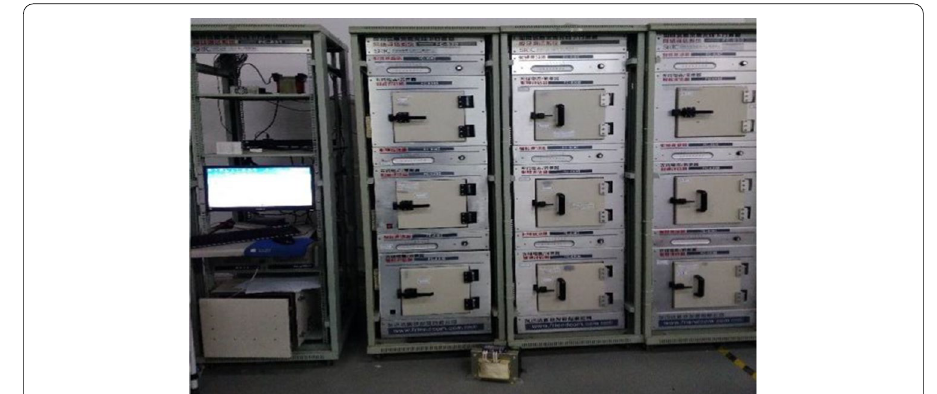
Fig. 10 Test platform of dual-mode heterogeneous field network in laboratory